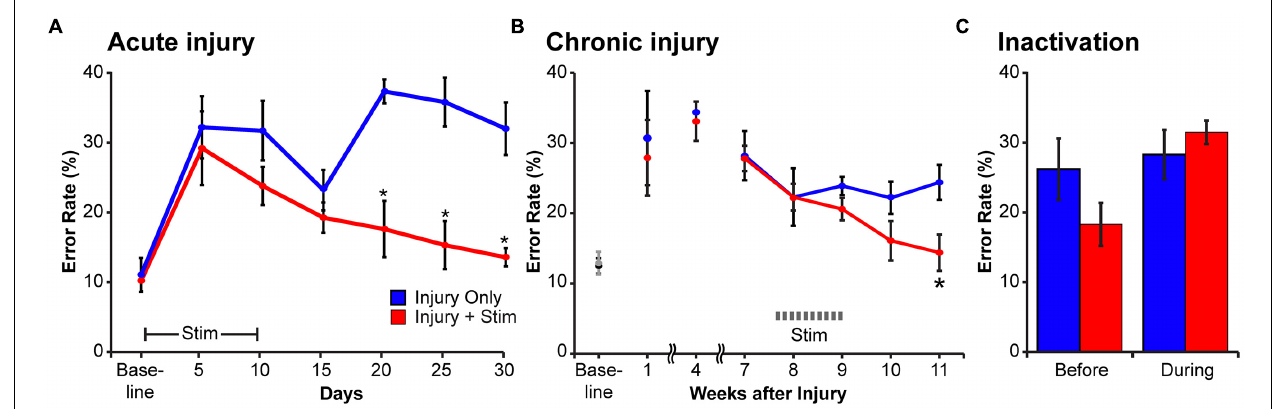
measures ANOVA, with Bonferroni post hoc correction, asterisk, p = 0.03). (C) After stimulation, motor cortex inactivation reinstates the motor impairment. After completion of motor cortex stimulation, performance on the horizontal ladder was measured before and during inactivation. In the rats with injury only, inactivation did not change the error rate in the impaired forelimb (blue bars are not different). In contrast, in rats with injury and stimulation (red bars) inactivation of the stimulated motor cortex reinstated their initial deficit in the ipsilateral forelimb (paired t -test, p = 0.01). (B,C) were modified from Carmel etal.